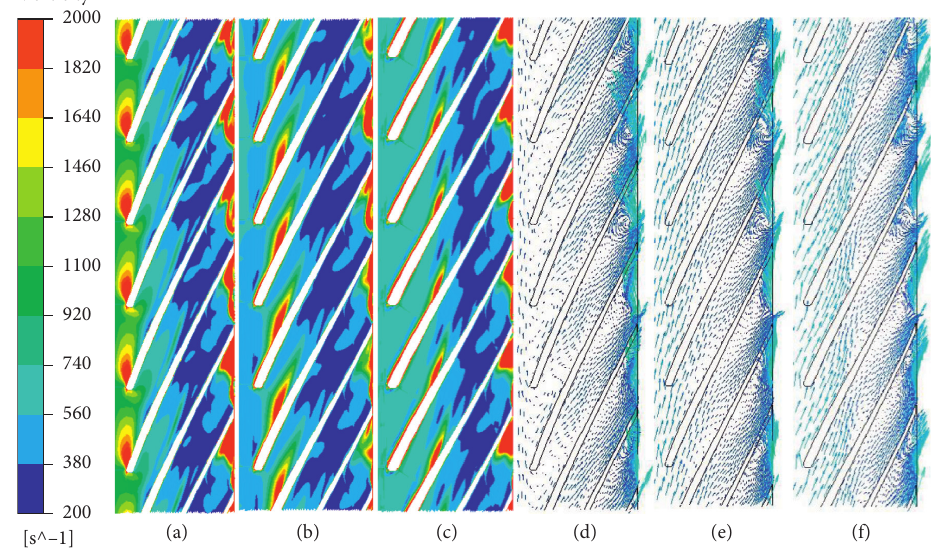
Figure 8: The distribution of vorticity and velocity vector. (a) SP 0.85. (b) SP 0.5. (c) SP 0.15. (d) SP 0.85. (e) SP 0.5. (f) SP